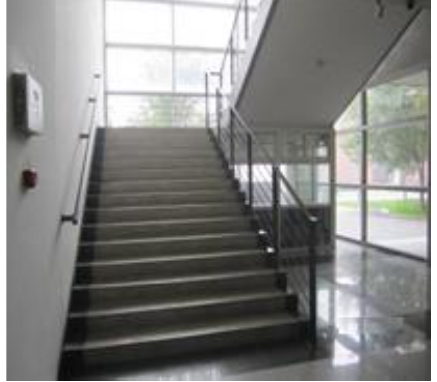
Figure 2. Selected stair.